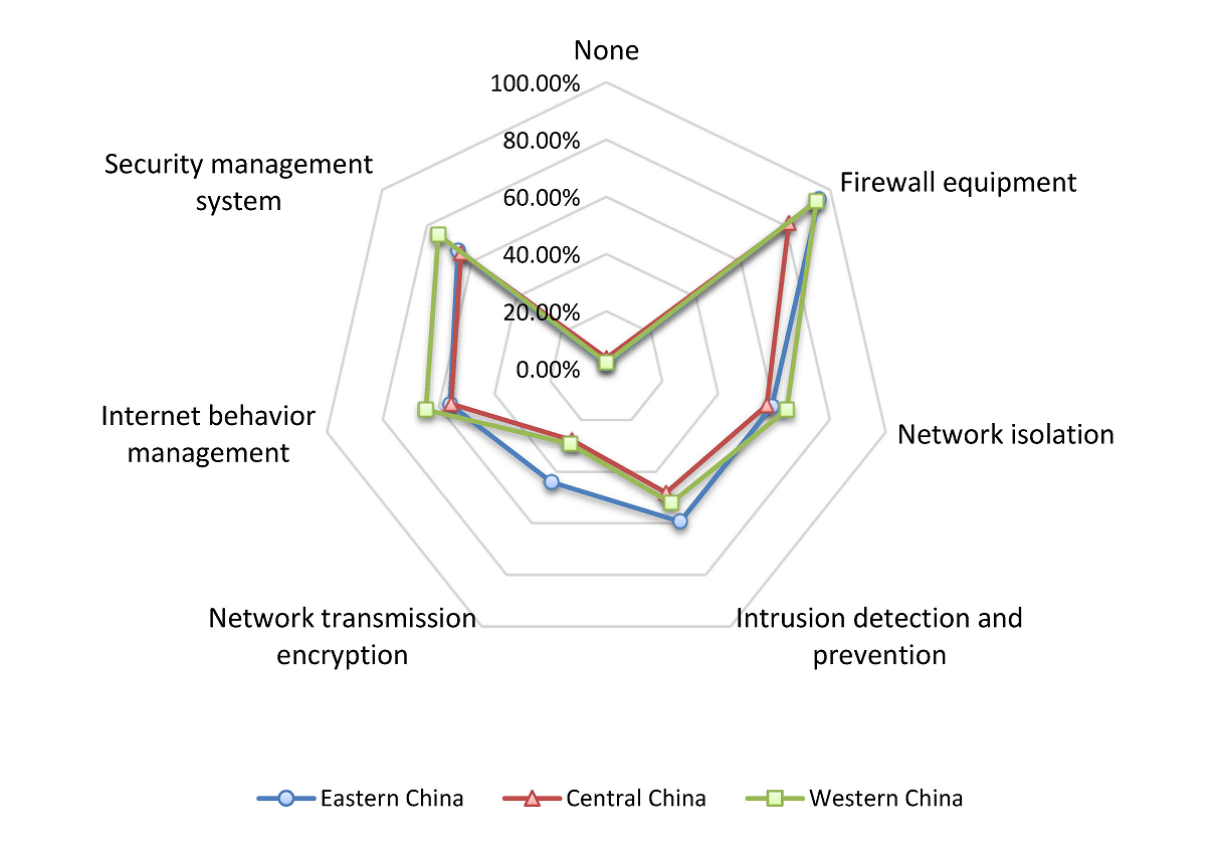
Figure 3. Telemedicine network security measures of tertiary hospitals in different regions of